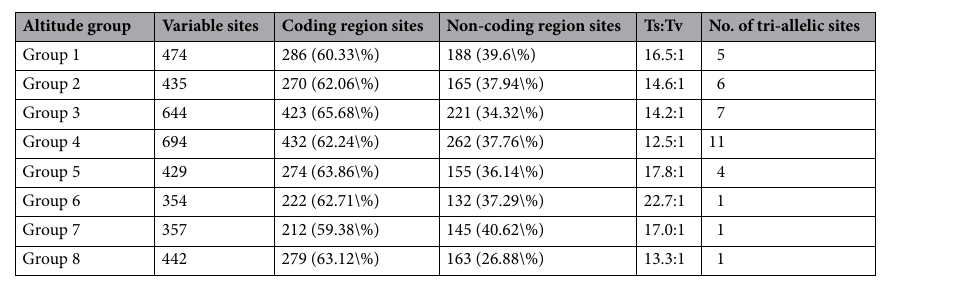
Table 1. Statistics of variable